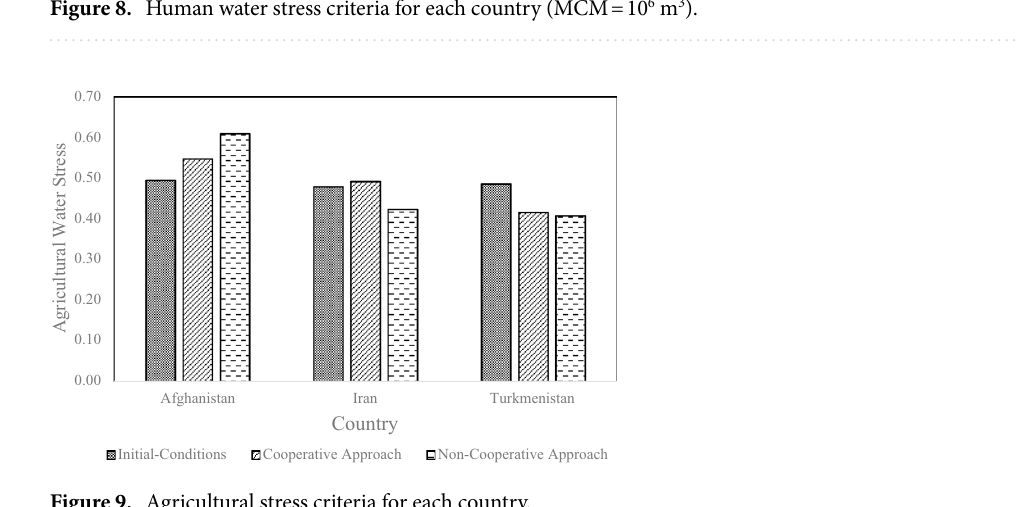
Figure 8. Human water stress criteria for each country (MCM = 10 6 m 3 ).